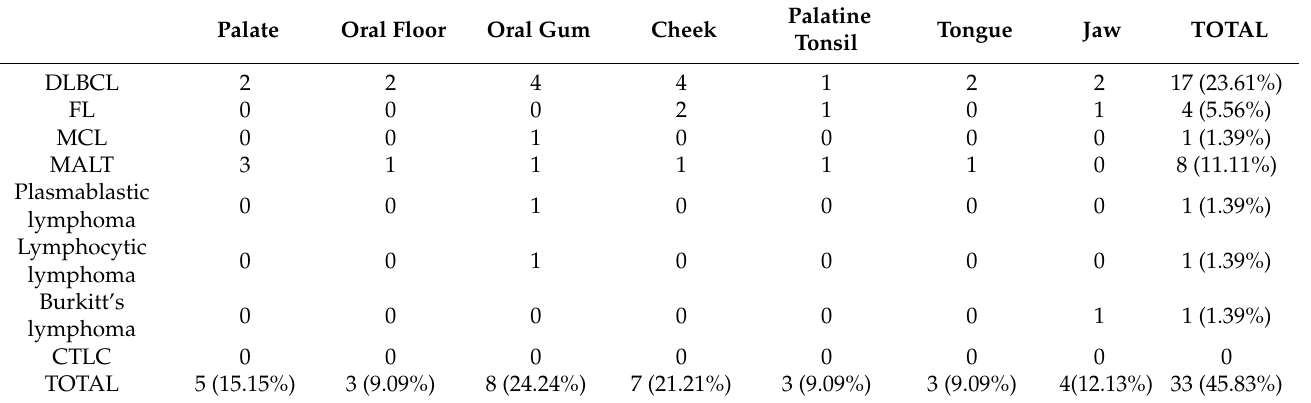
Table 2. Histology and localization of oral ENHLs.